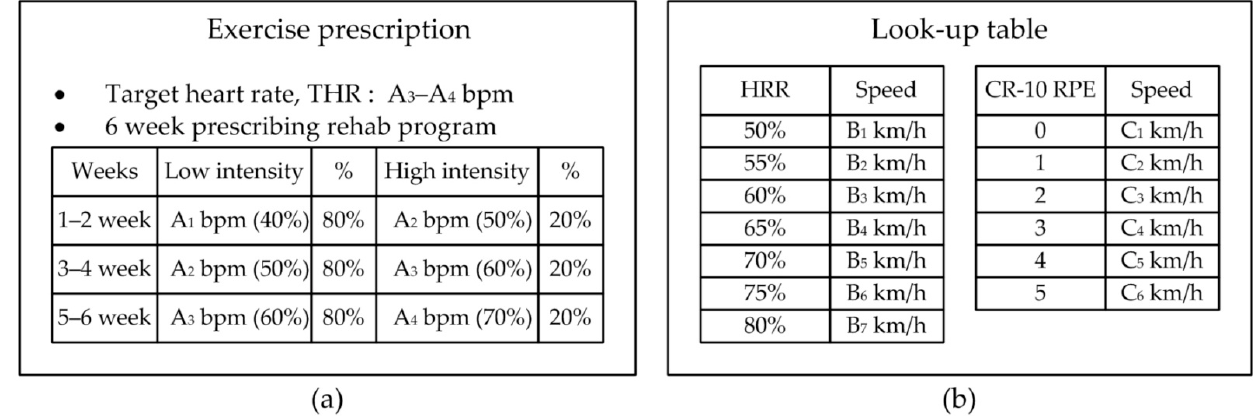
Figure 7. User input information to set the proposed therapeutic exercise platform; ( a ) Example of exercise prescription based on the exercise stress test, ( b ) look-up table to calculate exercise intensity based on HRR and CR-10